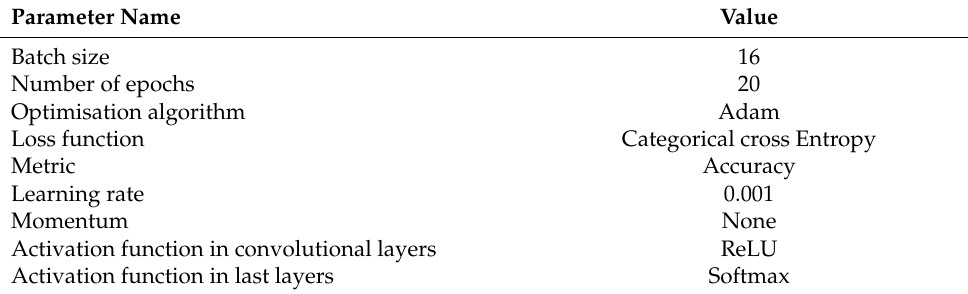
Table 4. Hyperparameter